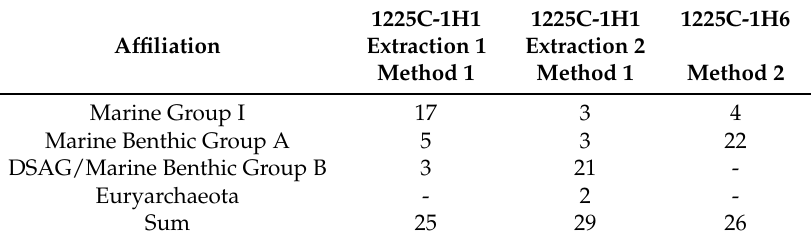
Table 2. Numbers of 16S rRNA gene clones affiliated with major archaeal groups retrieved after DNA extractions from Site 1225 sediment samples. The two replicate extractions for sediment sample 1225-1H1 are separated into two data